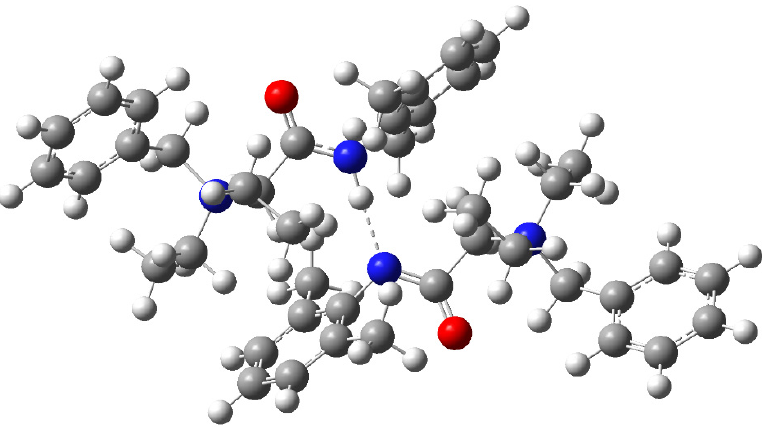
Figure 5. Calculated structure of non-covalent denatonium cation dimer with the strong N..H-N hydrogen bond.